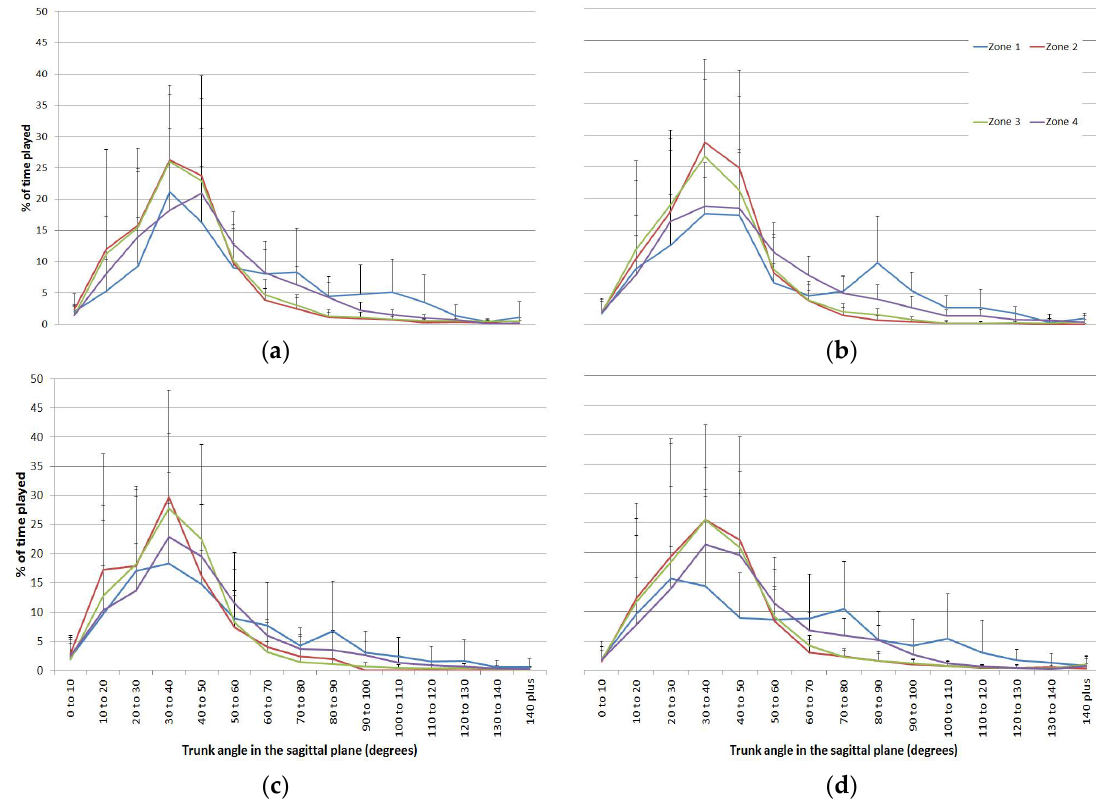
Figure 2. Range of mean trunk angles expressed during the ( a ) 1st quarter; ( b ) 2nd quarter; ( c ) 3rd quarter; and ( d ) 4th quarter while in the identified zones of the playing